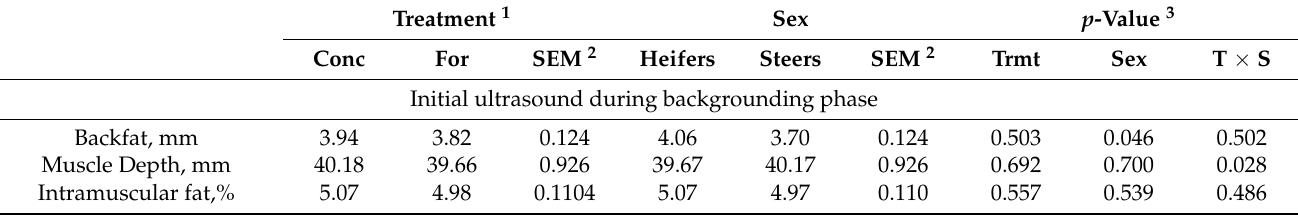
Table 4. Least square means for ultrasound measurements of progeny from dams fed a prepartum dietary carbohydrate source consisting of concentrate-based (Conc) or forage-based (For) diet during mid- and late-gestation. Treatment 1 Sex Conc For SEM 2 Initial ultrasound during backgrounding phase Backfat, mm Muscle Depth, mm Intramuscular